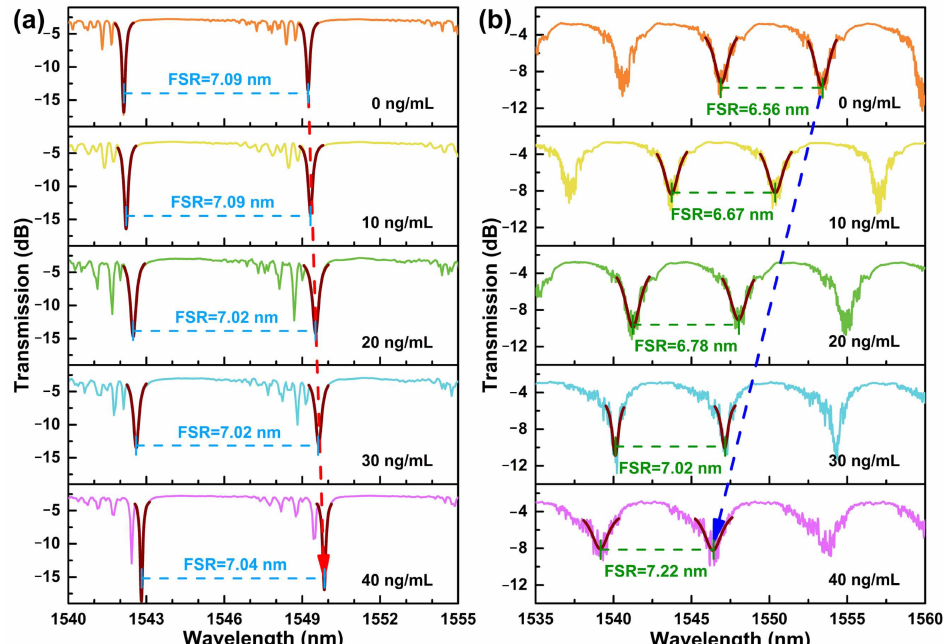
Figure 5. WGM spectral evolutions of ( a ) the non-LC modified and ( b ) the LC modified HGMSs with increasing cTnI-C concentration. The red and blue arrows indicate the redshift and blueshift of the resonant